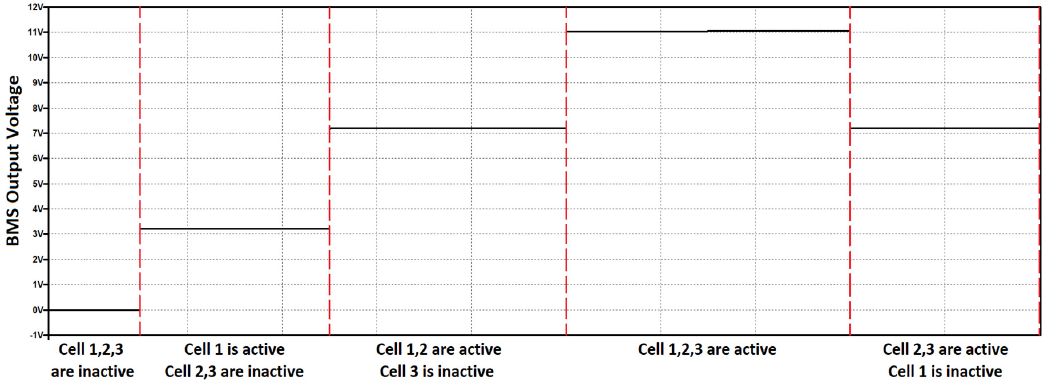
Figure 4. Results of switching unit simulation according to cell activation.